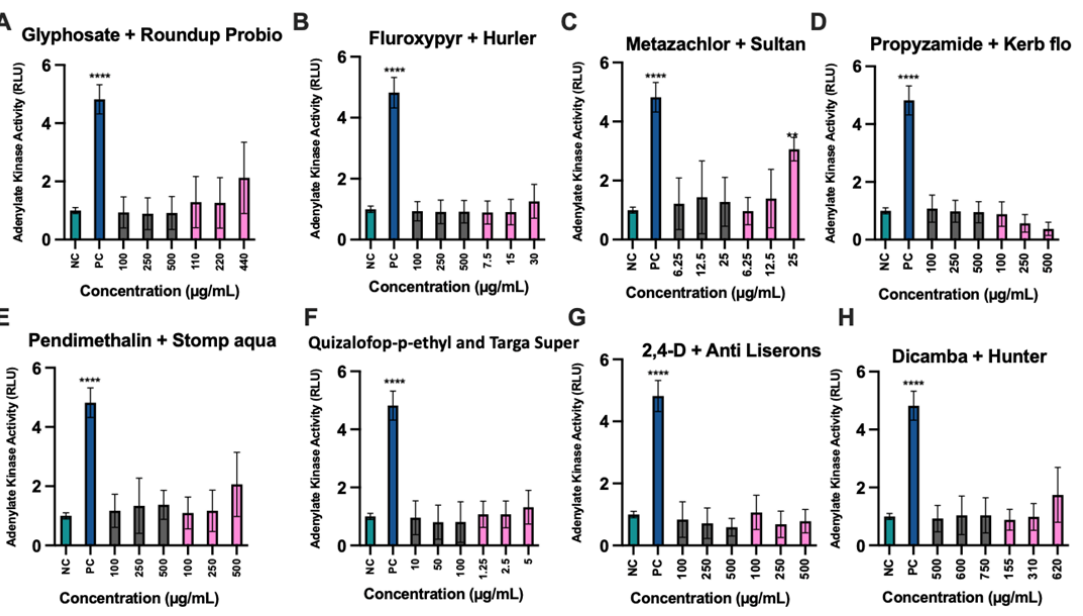
Figure 3. Measurement of membrane disruption cytotoxicity of herbicide active principles (grey columns) and their representative commercial formulations (pink columns) in human hepatocyte HepG2 cells. Untreated negative control cultures (NC), positive control cultures (PC) treated with 0.05% Triton X100 compared to each active ingredient (grey columns) and its respective commercial formulation (pink columns) 24 h after exposure. Adenylate kinase activity is expressed in relative units (RLU). Standard deviation (SD) is shown in all instances (n = 9). ** p < 0.001, **** p < 0.0001, in a Man-Whitney test which followed a one-way ANOVA.